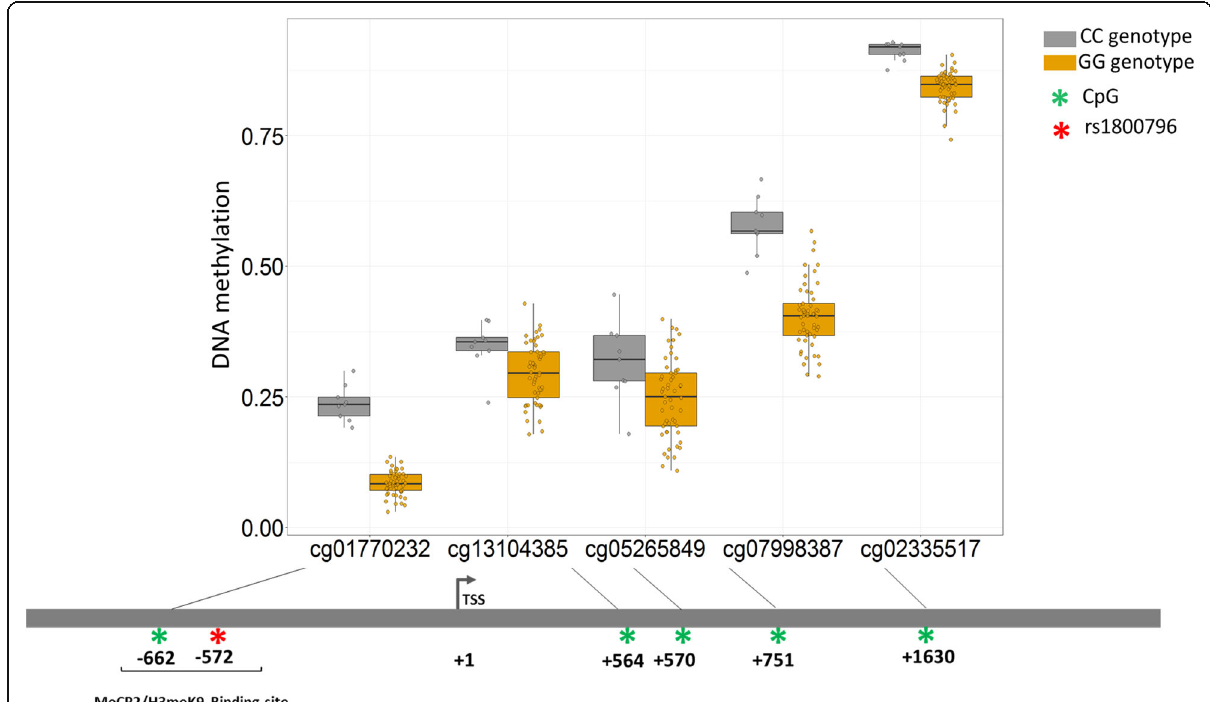
Fig. 3 Differentially methylated IL6 CpGs in chorionic villi associated with IL6 rs1800786 genotype. Unadjusted DNA methylation ( β ) values are plotted on the y-axis w.r.t the CpGs on the x-axis. Carriers of CC genotype showed increased DNA methylation levels compared to carriers of GG genotype, suggesting DNA methylation levels at these CpG sites are influenced by IL6 genotype. Position of the CpGs are indicated below the boxplots relative to the transcription start site (TSS) (UCSC